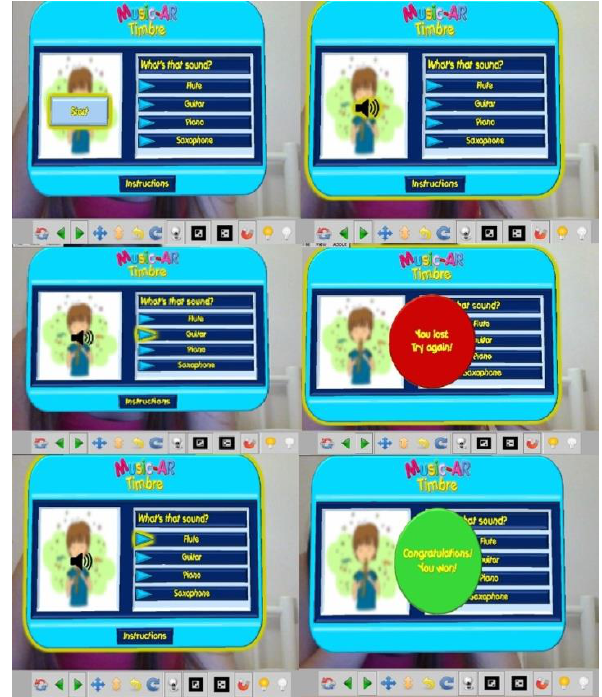
Figure 6. Main screens running the game on the Timbre